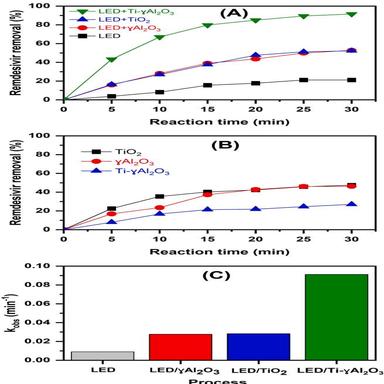
RDV removal in the presence of different oxidation processes under A) the photocatalytic activity (under UVA irradiation), B) adsorption (in absence of UVA), and C) Kinetic evaluation of the photocatalytic activity under UVA, using ɣAl2O3, TiO2, and Ti-ɣAl2O3 as-made materials in removing RDV (pH: 7; RDV: 10 mg/L; catalyst (when added): 50 mg/L).